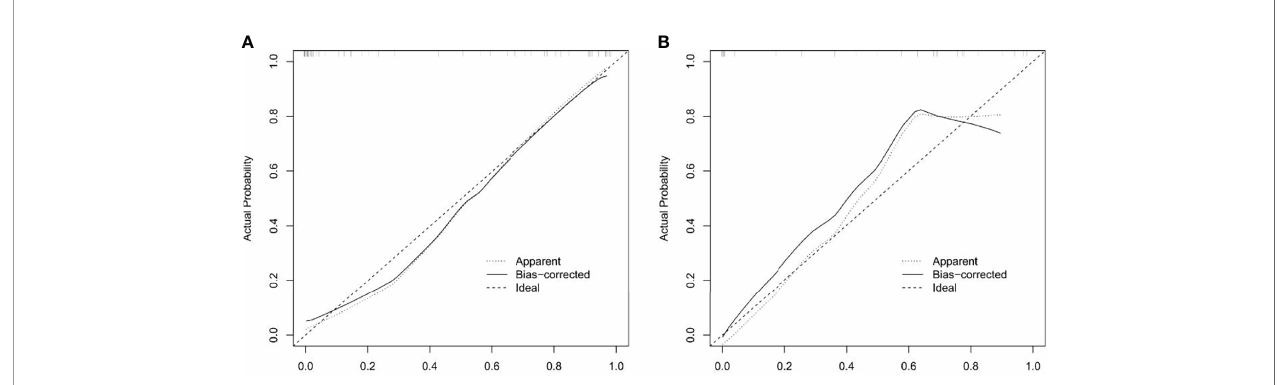
FIGURE 5 | Calibration curves of radiomics nomogram in training and validation cohorts. Calibration curve plots demonstrate the calibration between predicted risks of HER2-positive status and observed outcomes of HER2-positive status in the training cohort (A) and the validation cohort (B) .